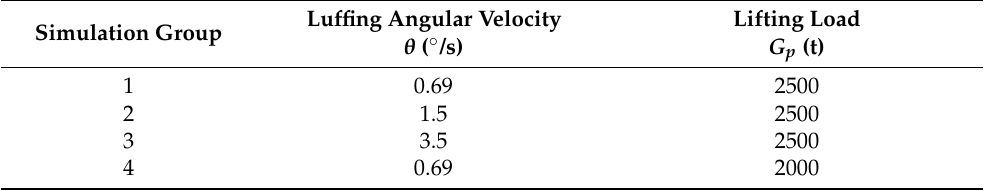
Table 2. Setting of the Simulation Parameters.